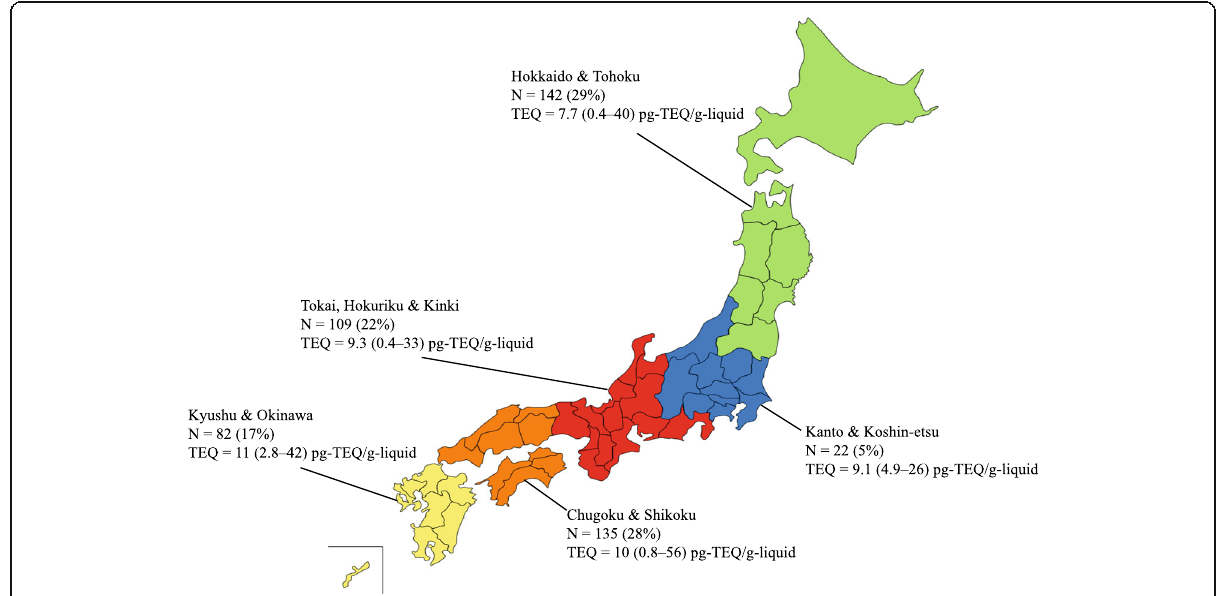
Fig. 1 Map of Japan showing the origins of the 490 participants [ N (%)] and their median blood dioxin total TEQ (range) in pg TEQ/g lipid. The geographic patterns of total TEQ presented in each region do not refer to region-level blood dioxin estimates. Instead, this geographic distribution represents the participants involved in this study. Definition of abbreviations: TEQ, toxic